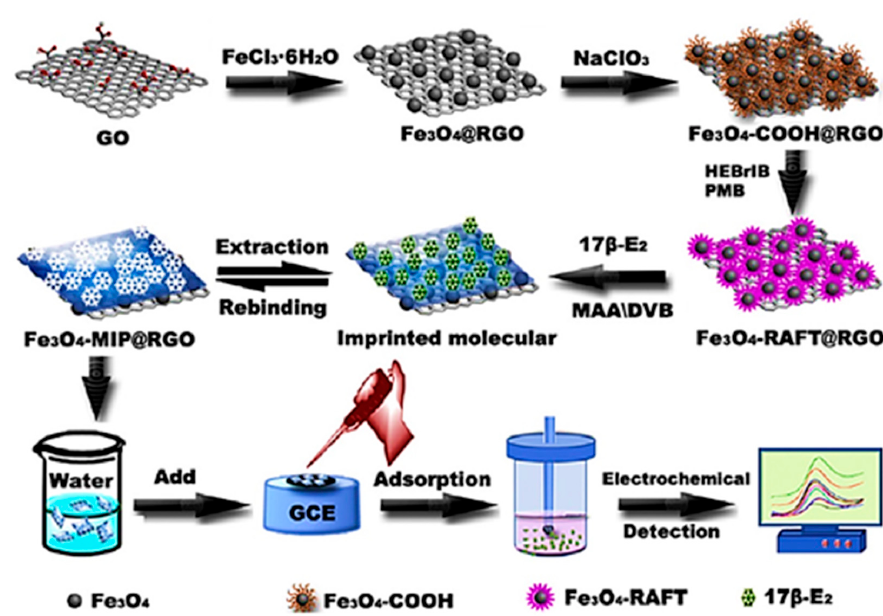
Figure 2. General scheme of Fe 3 O 4 -MIP-rGO / GCE sensor development and electroanalytical signal related to the oxidation of 17 β -estradiol (reproduced from [84], with permission from Elsevier, 2015).